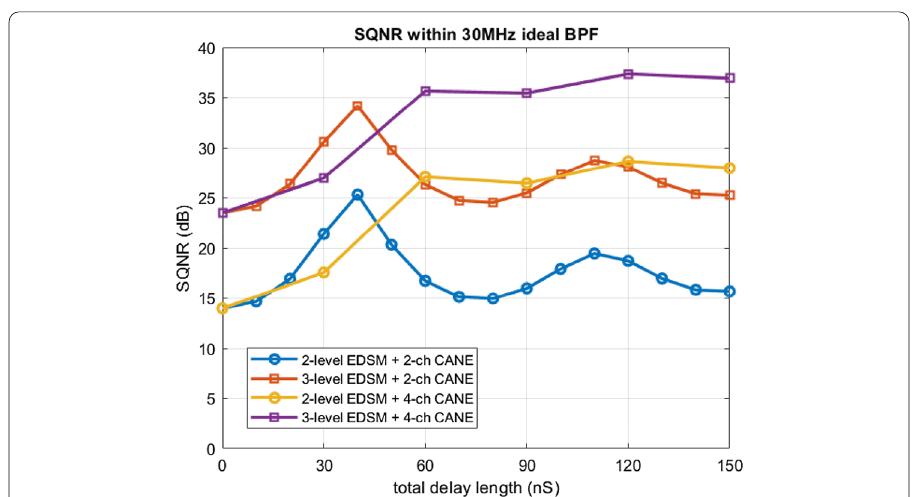
Fig. 5 Simulated SQNR of QPSK signal in EDSM